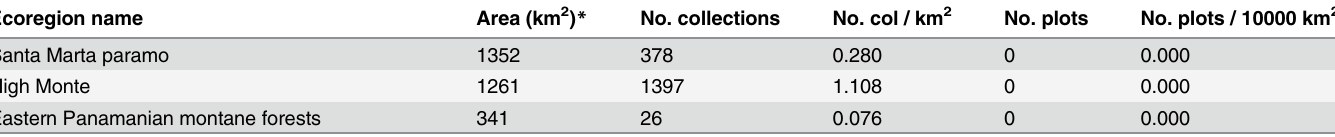
a plot; 33.8% is within 100 km of a plot; and 86.7% is within 500 km of a plot. The greatest dis- tance from any point in tropical South America to its closest of the included plots is 1273.3